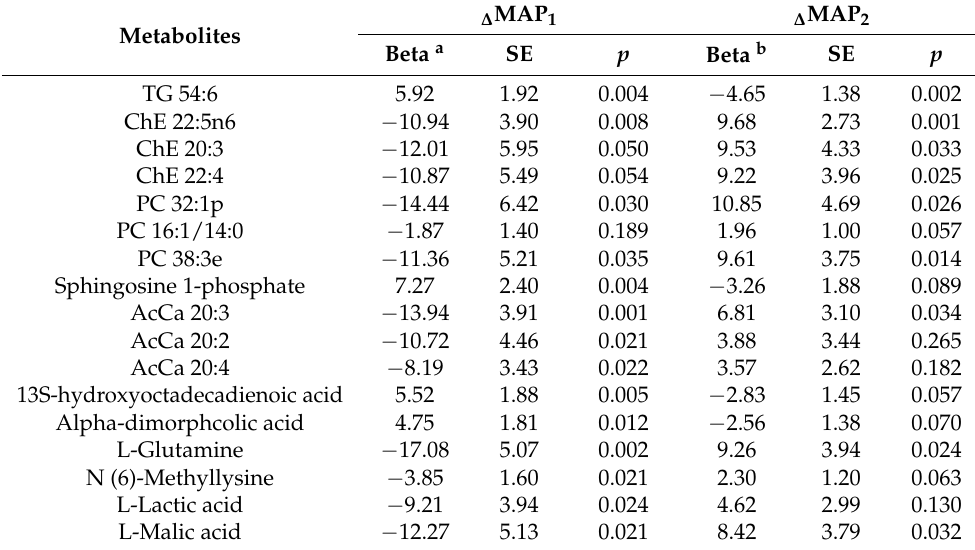
Table 3. Results of metabolites related regression models for Saline load period ( ∆ MAP 1 ) and Diuresis shrinkage period ( ∆ MAP 2